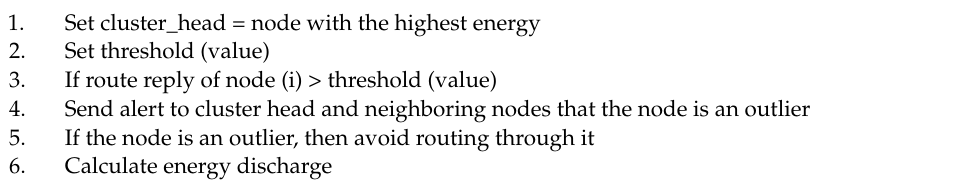
Algorithm 4: Energy calculation and identification of outliers